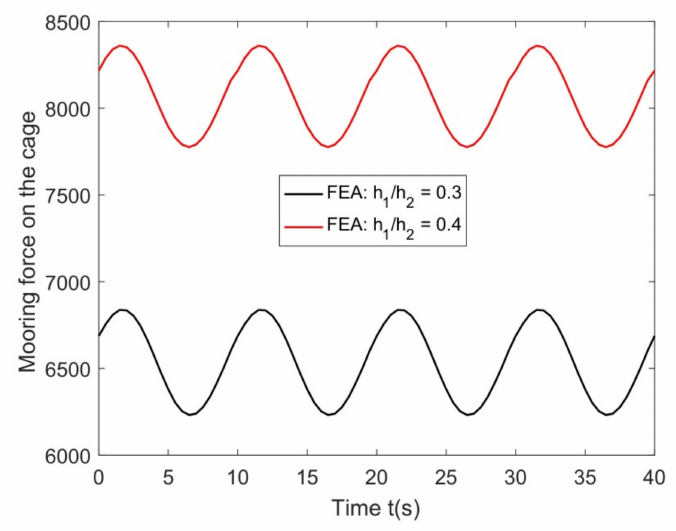
Figure 8. Effects of different cage heights h 1 versus time t(s) for a water depth h 1 = 50 m, k s = 10 3 Nm − 1 , and current speed u = 0.5